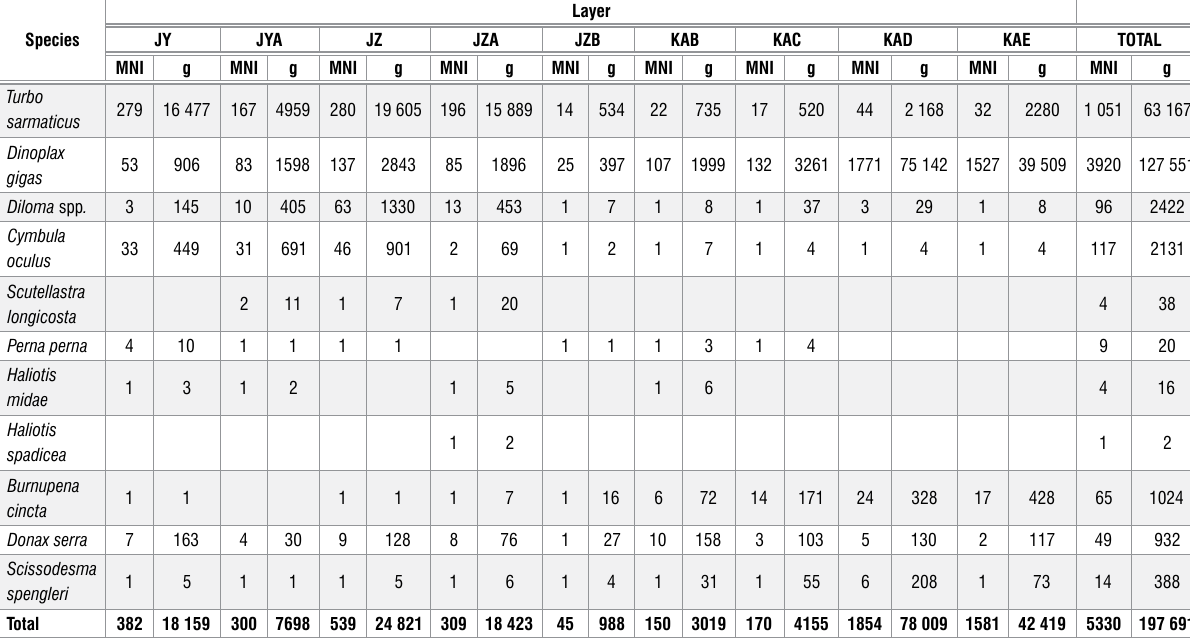
Klipdrift Cave: Minimum number of individuals (MNI) and weight (g) of shellfish from the Oakhurst layers Species JY Turbo